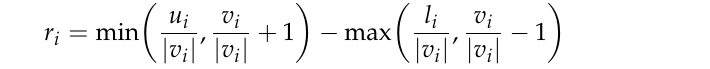
Comparison of measured and simulated [ 2 H]BHB MID, Figure S3: Characteristics of mice used for